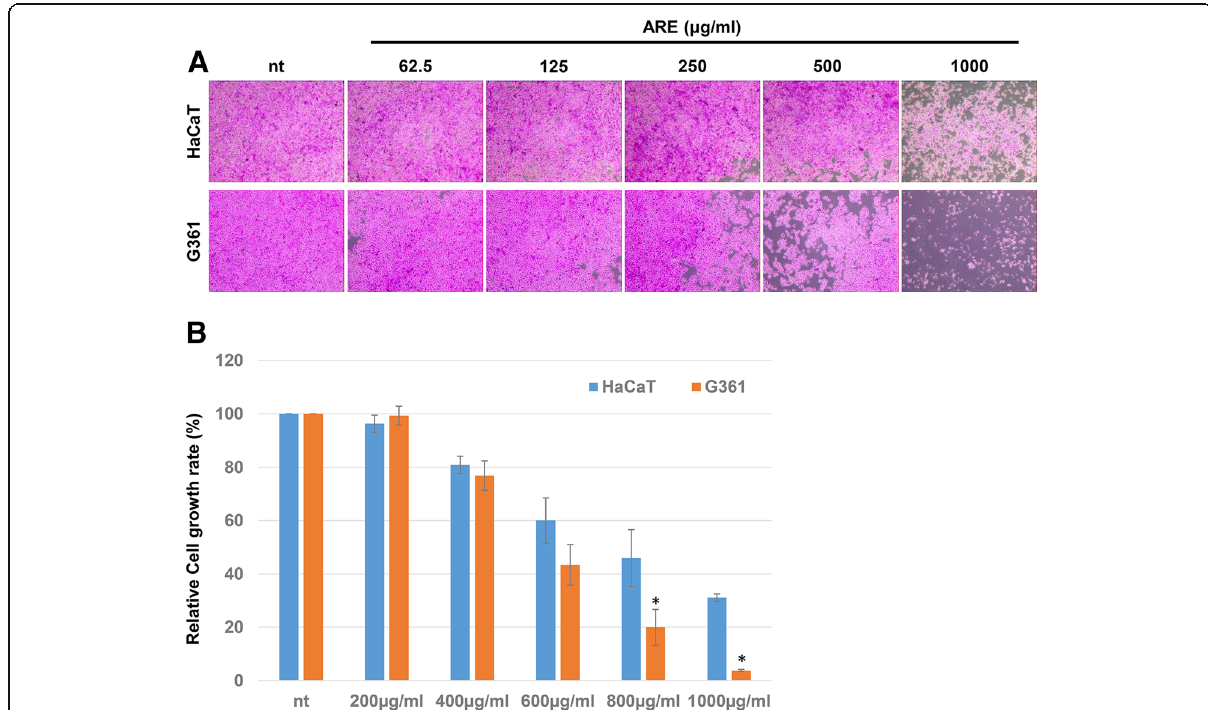
Fig. 1 Dose-dependent effects of ethanolic extract of asiasari radix (ARE) on the growth of G361 melanoma cells and HaCaT keratinocytes. a Microscopic images of G361 and HaCaT cells after 24 h of incubation with 0, 62.5, 125, 250, 500, and 1000 μ g/ml of ARE. Total cellular protein was stained with SRB; data shown are representative of three independent experiments. b Dose-dependent effects of ARE (200, 400, 600, 800 and 1000 μ g/ml) on the growth rate of G361 and HaCaT cells were tested at 24 h after the treatment, using the SRB assay. Data represent the mean ± SEM ( n = 4). The significant difference between HaCaT and G361 cells were marked as * ( p < 0.05); nt, non-treated